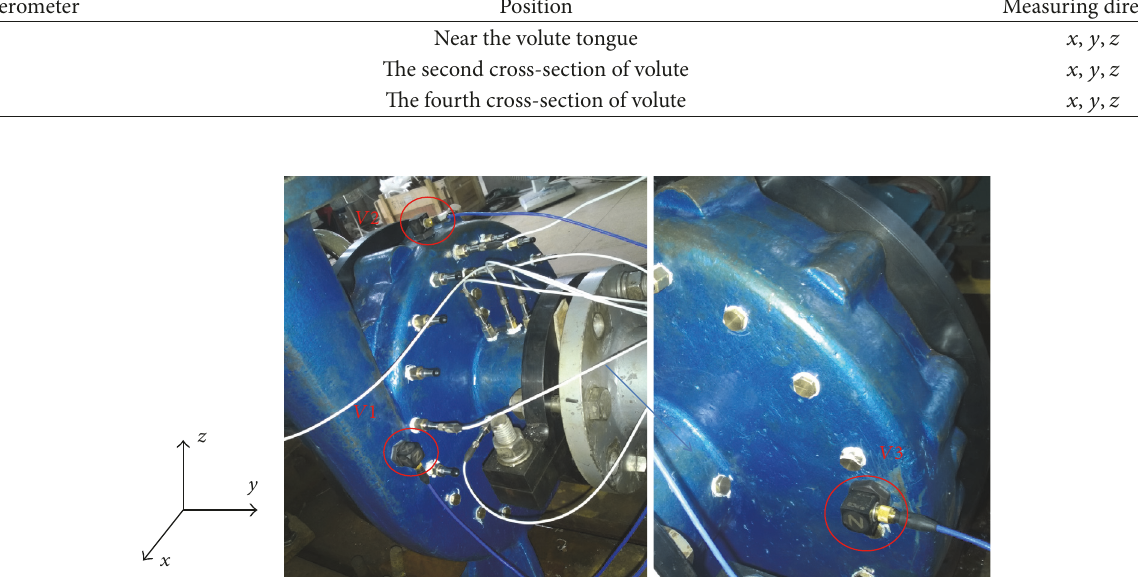
Figure 2: Positions of the accelerometers mounted on the volute casing.